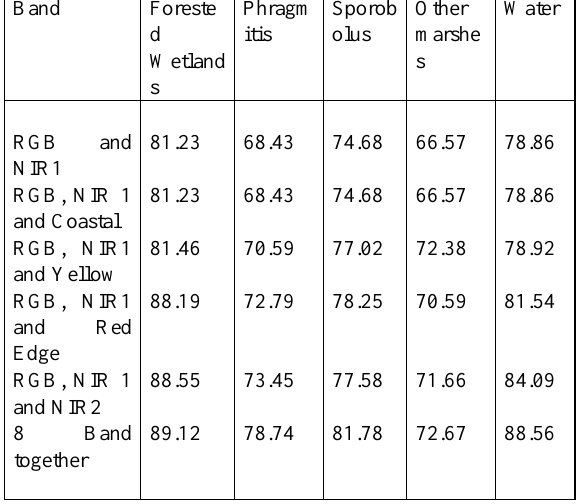
Table 3: Mapping Accuracy (%) of WORLDVIEW 2 data for the validation classes in saltmarsh area